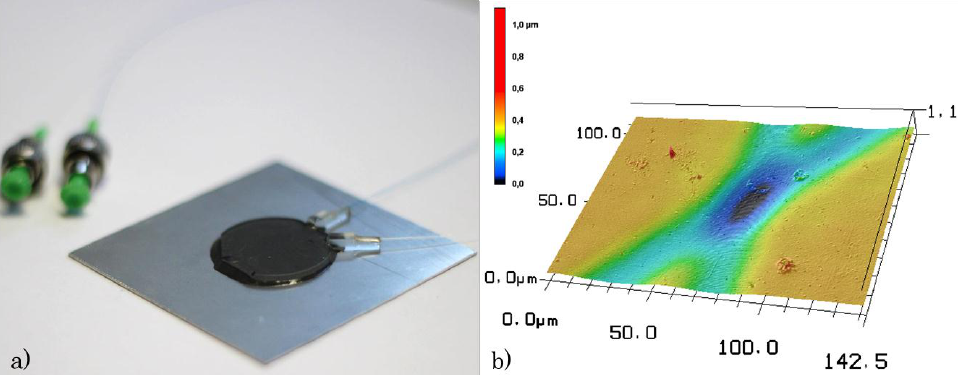
Figure 2. ( a ) Illustration of the 2D PPBG sensor chip in PMMA ontop a metal substrate. The two planar Bragg gratings intersect in the center of the PMMA platelet; ( b ) laser scanning microscopy image of the sensor chip surface at the intersection of the two waveguides with Bragg grating having an angular offset of